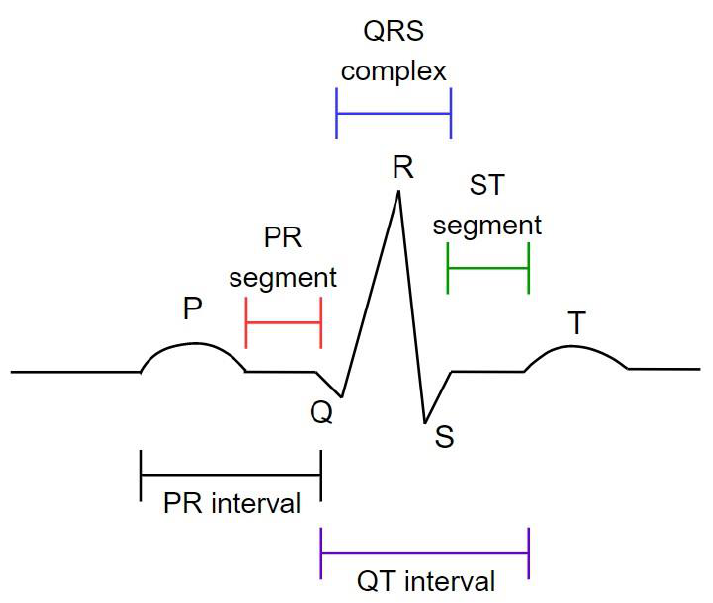
Figure 1. The P, QRS, and T waves in a single cycle of a standard ECG reading.